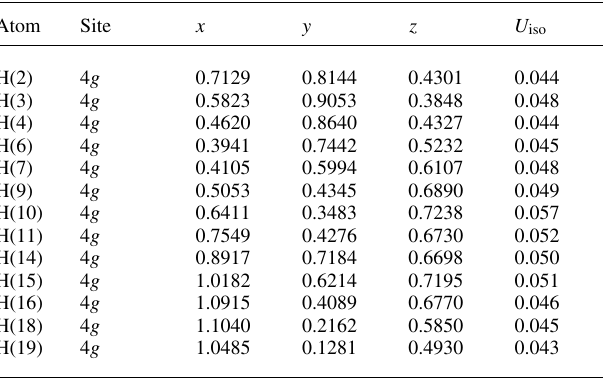
Table 2. Atomic coordinates and displacement parameters (in Å 2 )